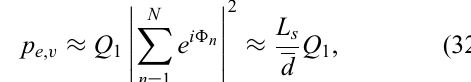
FIG. 12. Probability of occupying excited valley state, after two-step passage Q 2 for four different step separations d cor- responding to double height step d = 0 (green), valley collapse d ≈ 0.891 L dot (red), and interference d (cid:12) L dot (blue) as a func- tion of shuttling parameter η (lower scale) and electron velocity v (upper scale) for fixed E = 200 µ eV and L = 20 nm VS,0 dot ( E orb = 1 meV). We add the intermediate case of d = L dot (black) to show that d (cid:5) L dot distances between the steps should be suf- ficient to avoid the valley collapse. In the interference regime (blue), we compare analytical formulas for constructive inter- = 4 Q (cid:11) Q (cid:7) = 2 Q ference Q max 1 (solid line) and the average 2 1 2 (dashed line) against the results of numerical simulation